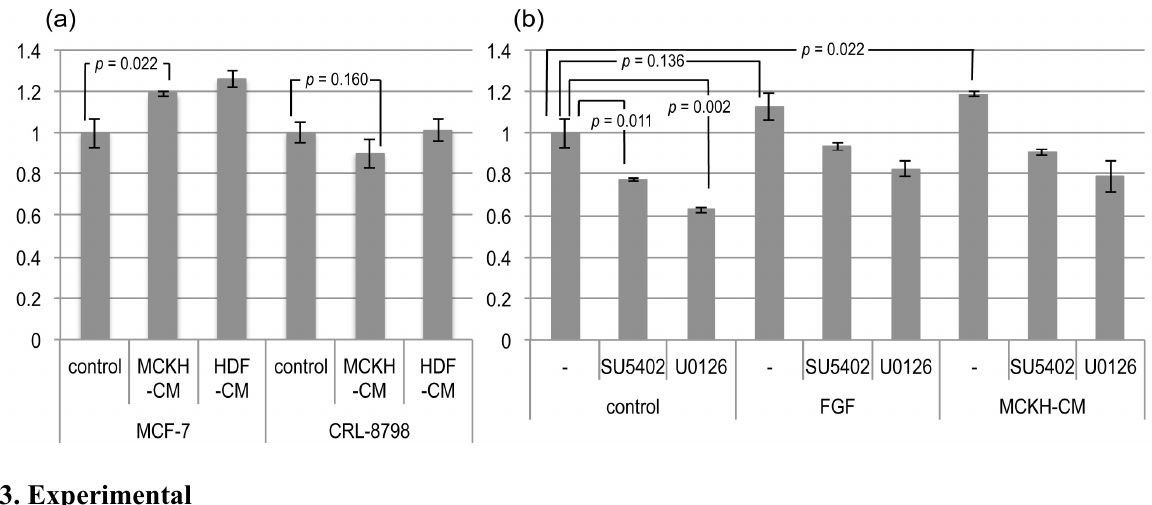
Figure 1. The effects of MCKH- and HDF-conditioned media (CM). ( a ) MCF-7, a human breast adenocarcinoma cell line, and CRL-8797, a normal mammary gland breast epithelial cell line, were cultured in freshly prepared MCF medium (control), MCKH-CM, and HDF-CM. Cell proliferation was assessed by using a 3-(4,5-dimethylthiazolyl-2)-2,5-diphenyltetrazolium bromide (MTT) method and evaluated relative to proliferation in the control medium. Some p -values of the t -tests are represented; ( b ) The effects of tyrosine-kinase inhibitors on the activity of MCKH-CM to MCF-7. MCF-7 was cultured in the control medium, FGF-fortified medium, and MCKH-CM, with (SU5402, U-126) or without ( − ) inhibitors. Cell proliferation was assessed using an MTT method and evaluated relative to proliferation in the control medium without